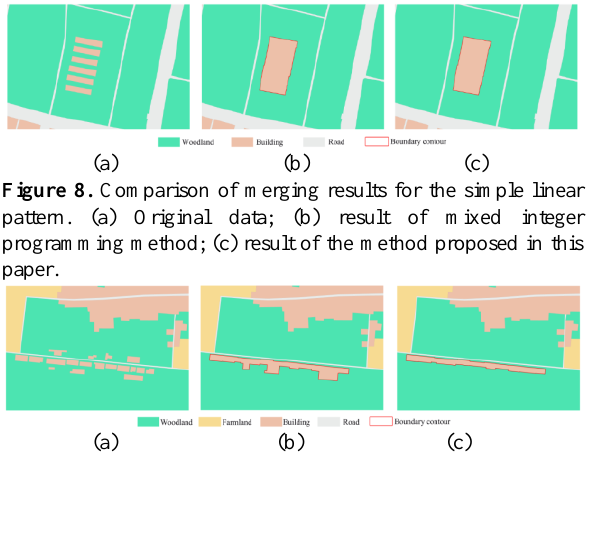
Fig. 11, the mixed integer programming method fails to